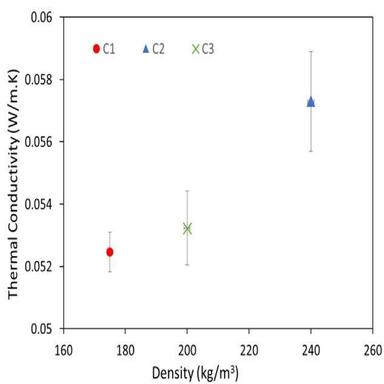
Thermal conductivity vs density of the composites.